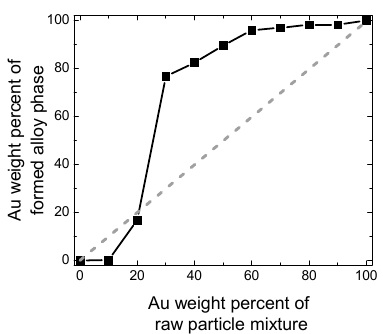
Figure 7. Relationship between the Au weight percentage of the raw particle solution and that of the formed alloy phase after laser irradiation.